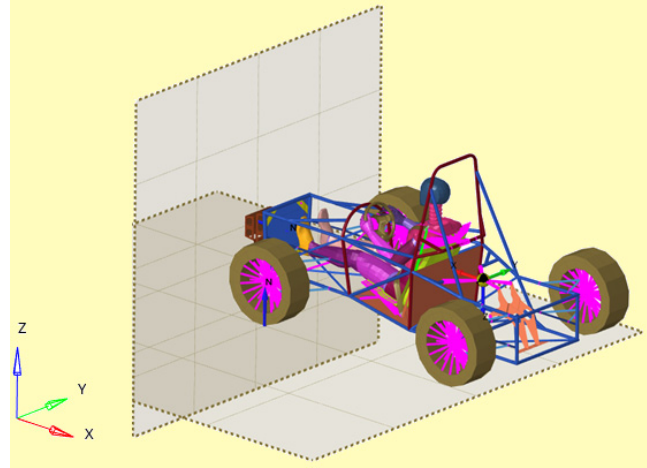
Figure 20. The wall is the reference in the presentation. The obtained peak deceleration was 40 g and the average deceleration was 20 g, which respects the aforementioned criteria (Figure 21). Figure 22 presents the deformed impact attenuator at different points in time. Figure 23 depicts the second-order acceler- ations.